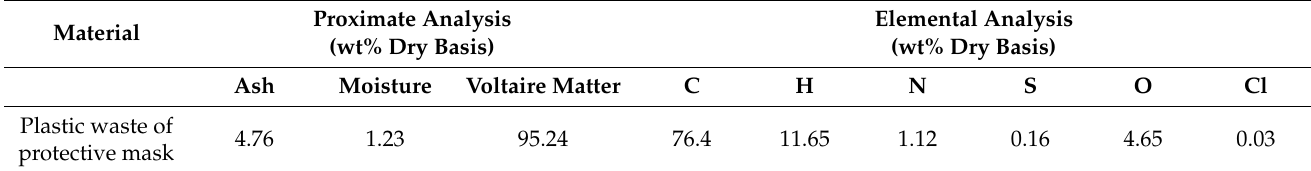
Table 2. Proximate and ultimate analysis of plastic waste of protective